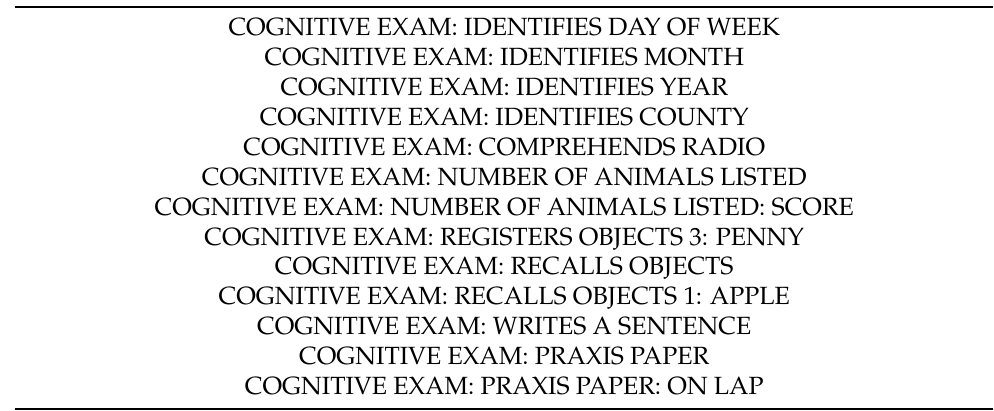
Table 3. Important Feature list for identifying misdiagnosed patients.